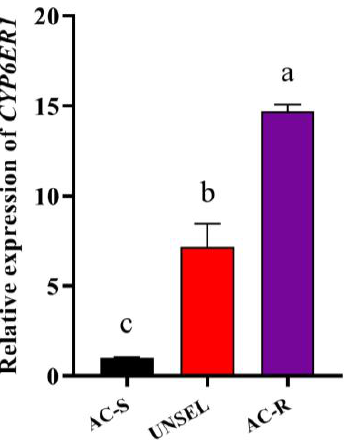
Figure 3. Relative expression levels of CYP6ER1 in AC-R (G 28 ) and UNSEL compared to AC-S. The bars with lowercase letters (a, b, c) are significantly different according to one-way ANOVA, fol- lowed by Tukey’s multiple comparison ( p < 0.05).